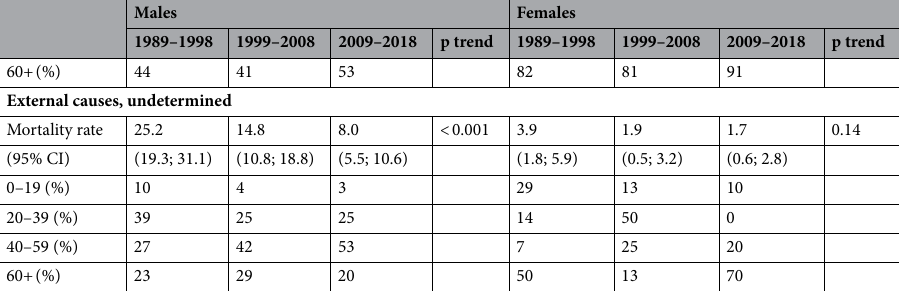
Table 4. Age-standardised mortality from broad categories of external causes according to sex and age in 1989–1998, 1999–2008 and 2009–2018. a E.g. limb fractures among the elderly, electrocution, shark attacks, hit by aircraft propeller, helicopter crashes, ship injuries, rock accidents, struck by falling objects, lightning, other asphyxiation, and injuries due to epileptic